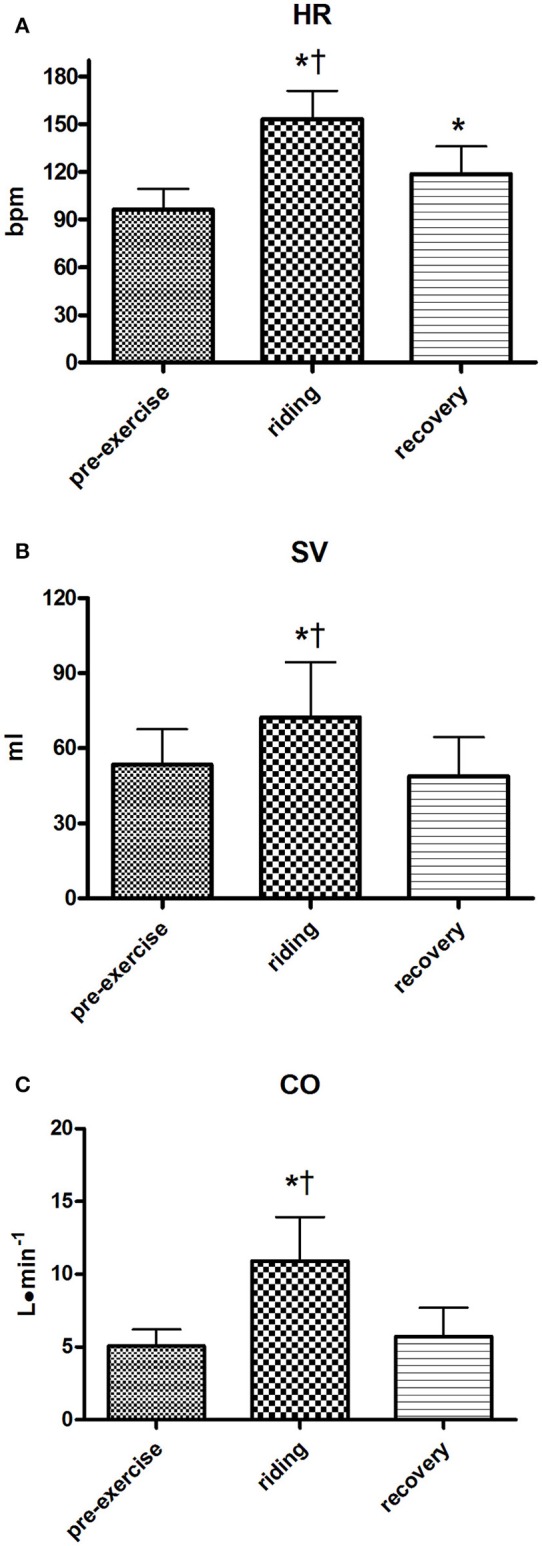
Group heart rate values (HR, A), stroke volume (SV, B), and cardiac output (CO, C) during the various periods of the Enduro session. Variables at rest were considered those of the last minute of rest preceding the motorcycle session, variables during riding were the average of the 10 min Enduro session, while variables at recovery were considered those of the third minute of recovery. Values are mean ± SD (n = 15). *p < 0.05 vs. pre-exercise; †p < 0.05 vs. recovery.